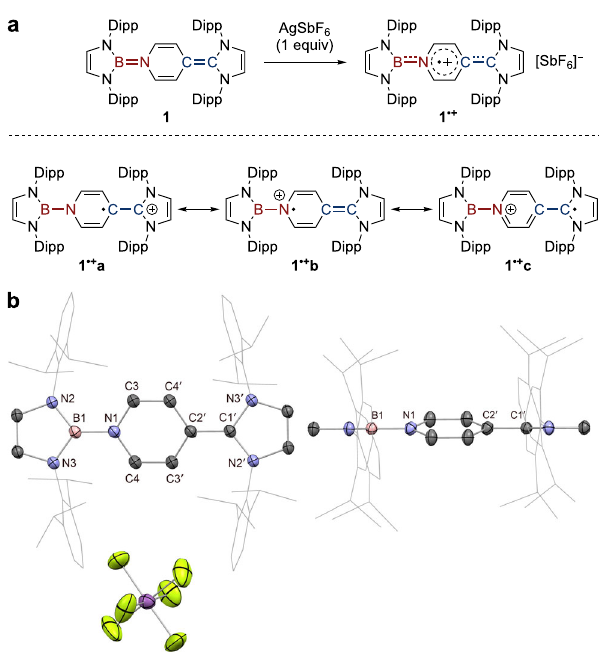
Fig. 4 Synthesis and characterization of radical cationic organoboron analogue of Thiele ’ s hydrocarbon. a Synthesis of 1 • + , showing contributing resonance structures. b Solid-state structure of 1 • + [SbF 6 ] with side view. For clarity, H atoms are omitted and Dipp groups are simpli fi ed as wireframes. Thermal ellipsoids set at 50% probability. Key distances (Å): B1 − N1 1.465(4), C1 ’ − C2 ’ 1.465(4), N1 − C3 1.407(4), N1 − C4 1.397(4), C3 − C4 ’ 1.363(4), C3 ’ − C4 1.363(4), C2 ’ − C4 ’ 1.397(4), C2 ’ − C3 ’ 1.407(4). (Fig. 5a). Interestingly, the 11 B hyper fi ne coupling constant (3.32 G) is larger than for diborene radical cations (< 1.18 G) 61,62 ,